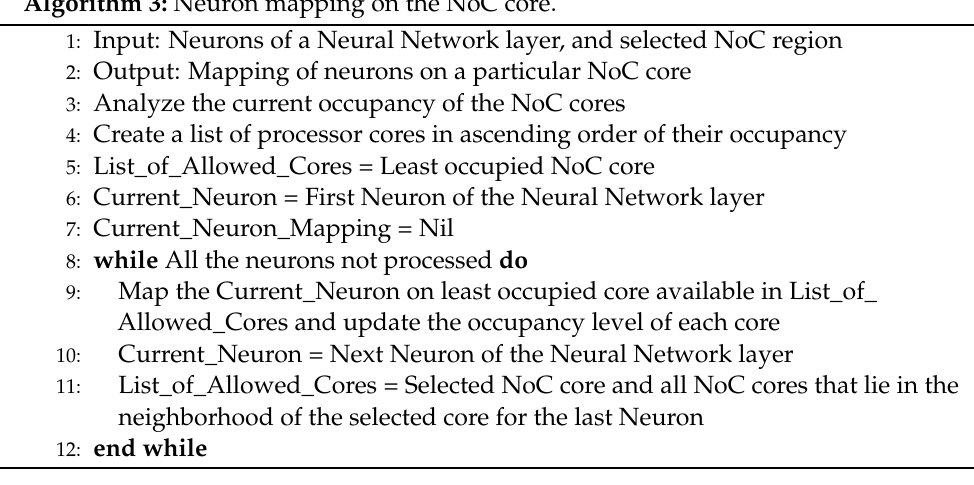
Figure 4. AI task mapping on processor cores. Algorithm 3: Neuron mapping on the NoC